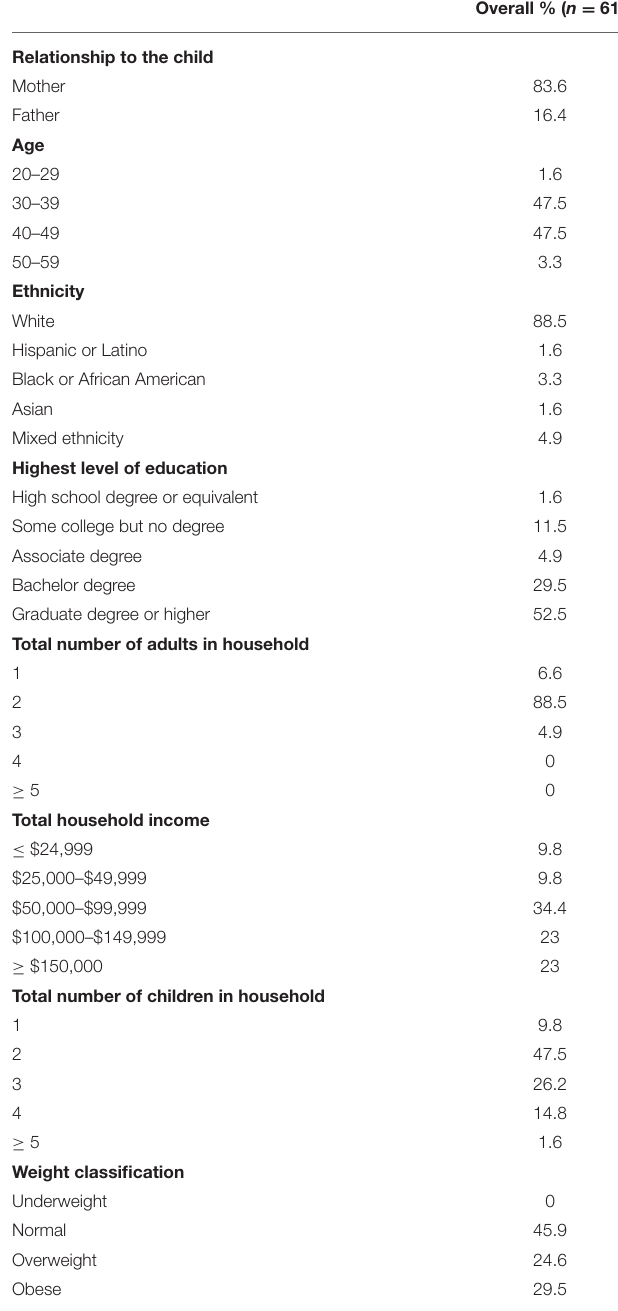
TABLE 2 | Socio-demographic characteristics of